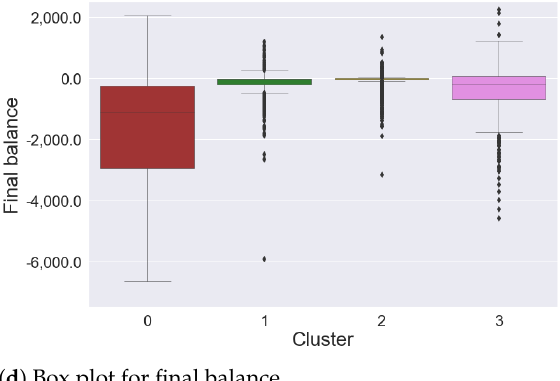
Figure 2. Box plots for sports bets’ data obtained using the time series k -means